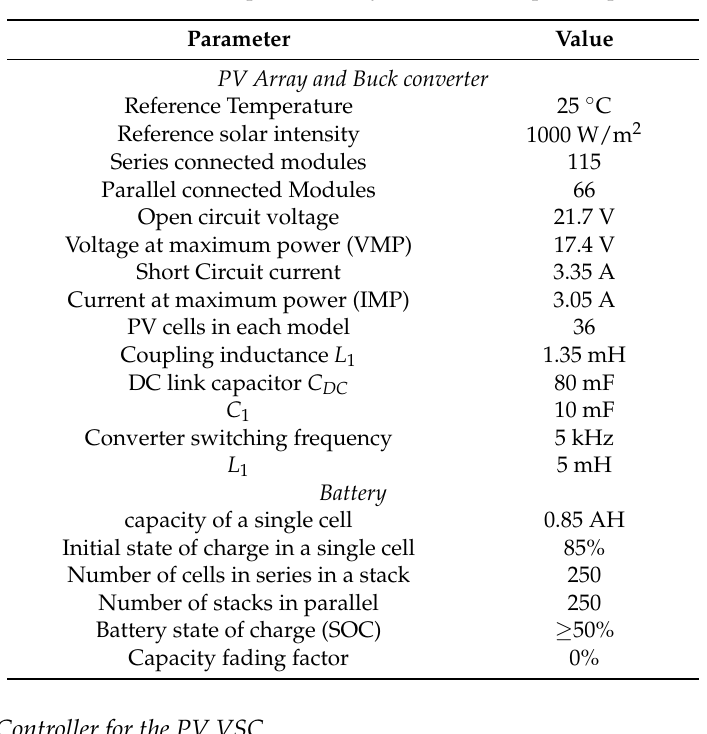
Table 1. Photovoltaic (PV) panel, battery and other component parameters.